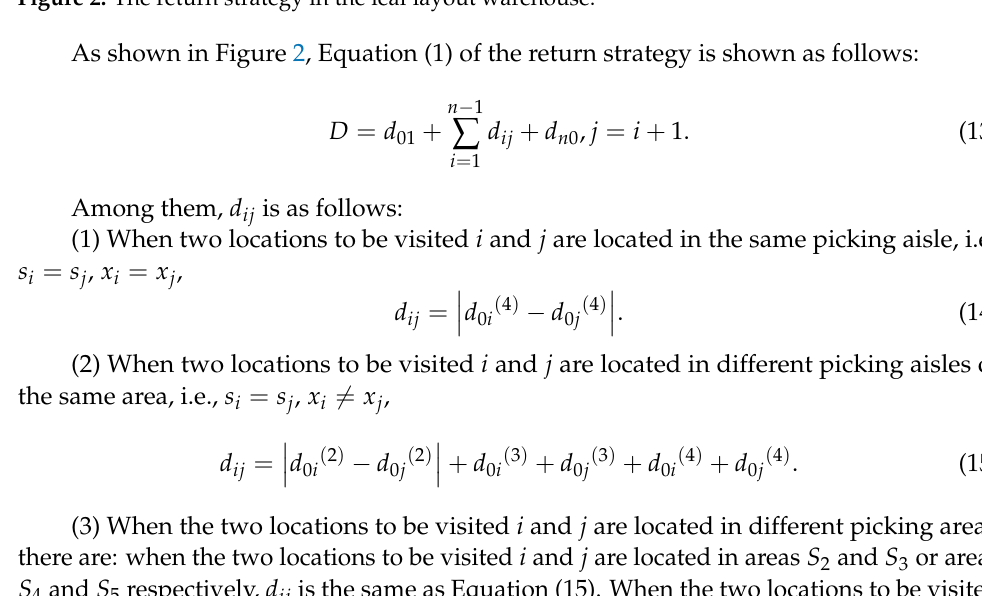
Figure 2. The return strategy in the leaf layout warehouse.